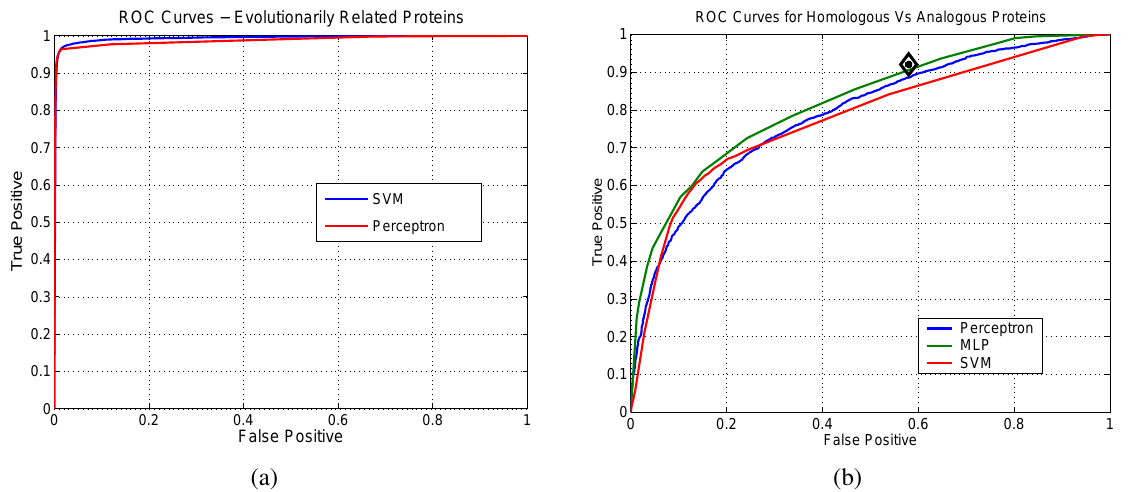
Figure 3: Performance of the classifiers shown as receiver operating characteristic (ROC) curves for the two problems considered: Evolutionary related vs unrelated, and homologous vs analogous. The diamond point on the latter graph indicates classification of pairs formed with protein 2hdda used in the test set (see